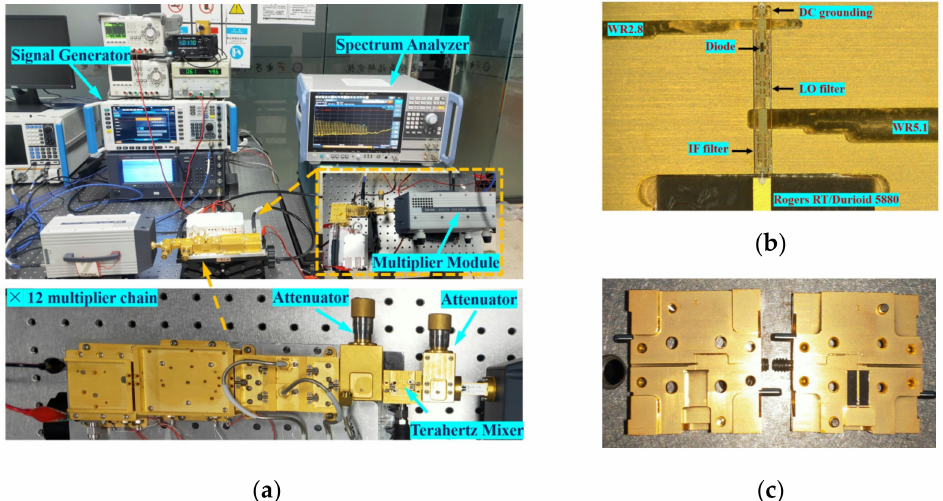
Figure 9. The measurement of the 0.34 THz sub-harmonic mixers and its photographs under a microscope. ( a ) Test scenarios for sub-harmonic mixers; ( b ) The photograph of the 0.34 THz mixer; ( c ) The photograph of the mixer